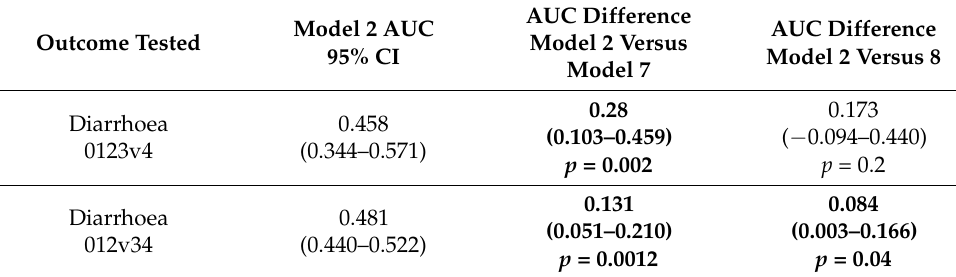
Table 3. Comparative ROC analysis of models for the prediction of